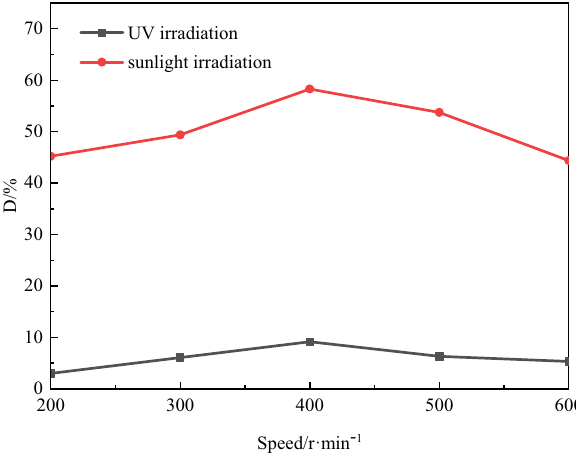
Figure 4: Photocatalytic degradation e ffi ciency of CdS/TiO 2 composite photocatalysts with di ff erent ball milling speeds.